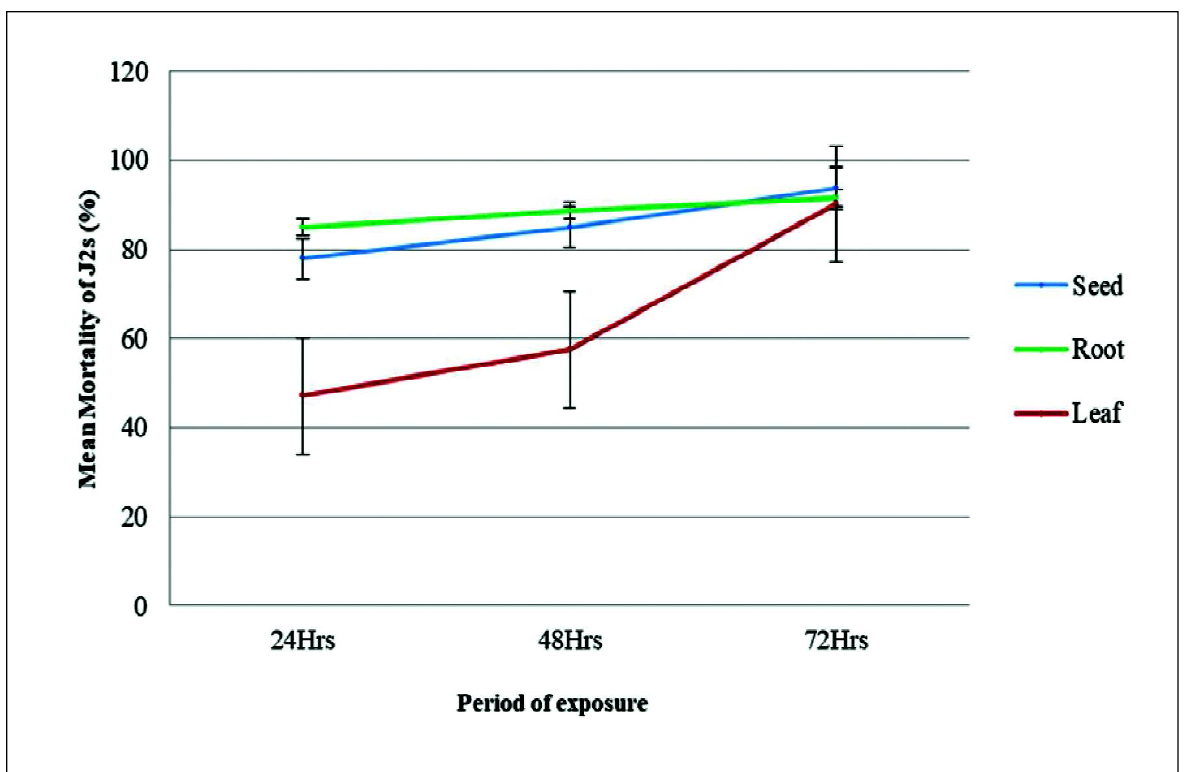
Figure 1: Comparison of effectiveness of seed, root and leaf extracts on J2s of G. rostochiensis